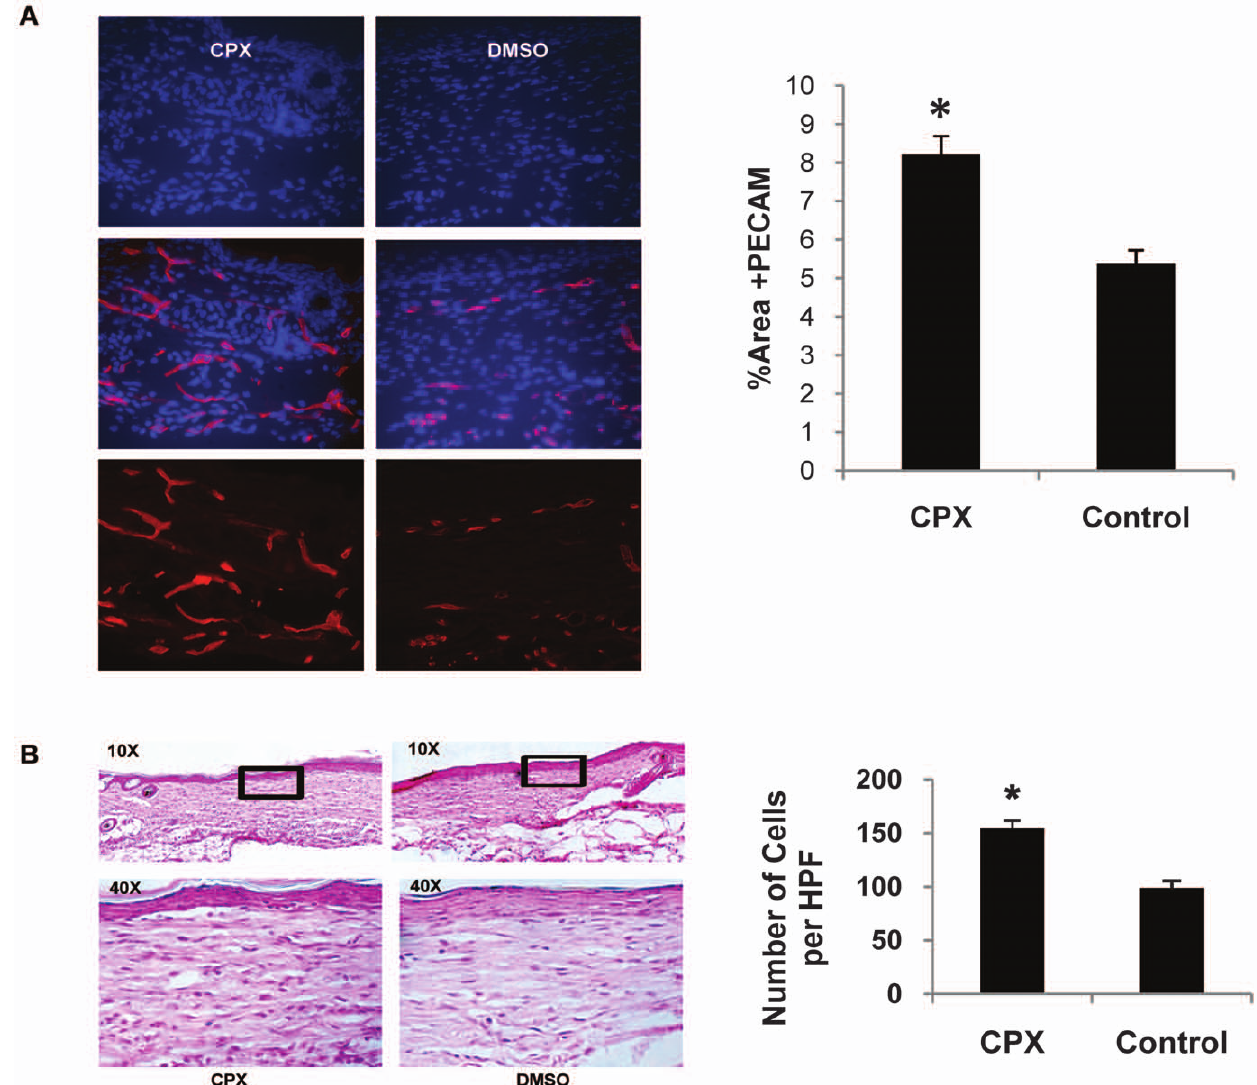
Figure 4. Histological analysis of wounded skin. ( A ) Effects of CPX on wound vascularity. Wound sections were stained with an anti-CD31 antibody and detected with Fluor 594 (red). Software-assisted quantification of vessel density in the entire area of residual wounds at day 22, as percent fluorescence. Wounds from CPX-treated mice had significantly higher vessel density compared with that from DMSO-treated mice (*p , 0.05). ( B ) Hematoxylin and Eosin stains of wound tissue after full closure at 22 days post-wounding (left). CPX-treated wounds have higher dermal cellularity in the wound bed compared to DMSO-treated control wounds. The black box indicates the area of healed wound depicted under high power view. Quantification of cellularity in the wound by counting total cell number per high-powered field views (10 6 40) (right).